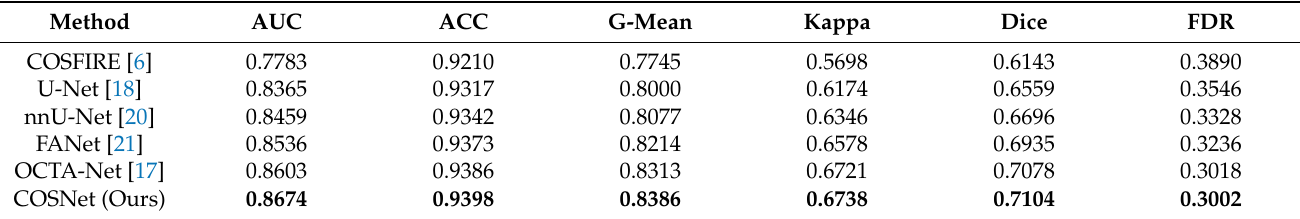
Table 4. Performance comparison on ROSE-2 *.